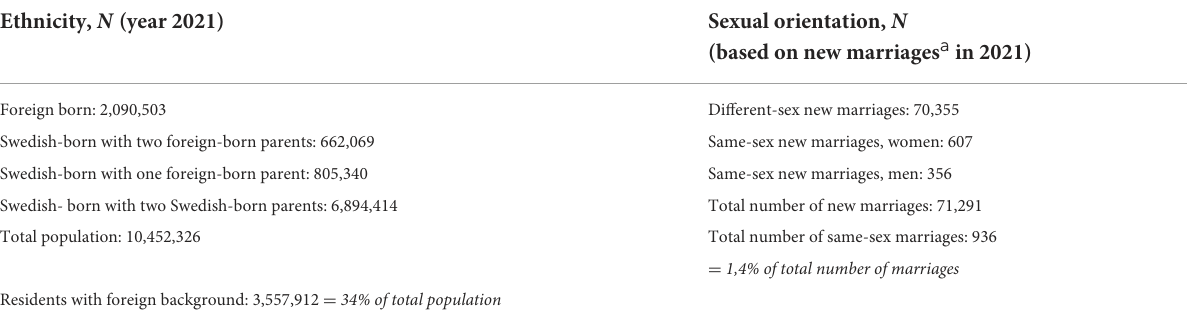
TABLE 1 Existing population data on the ethnic and sexual minority make-up of